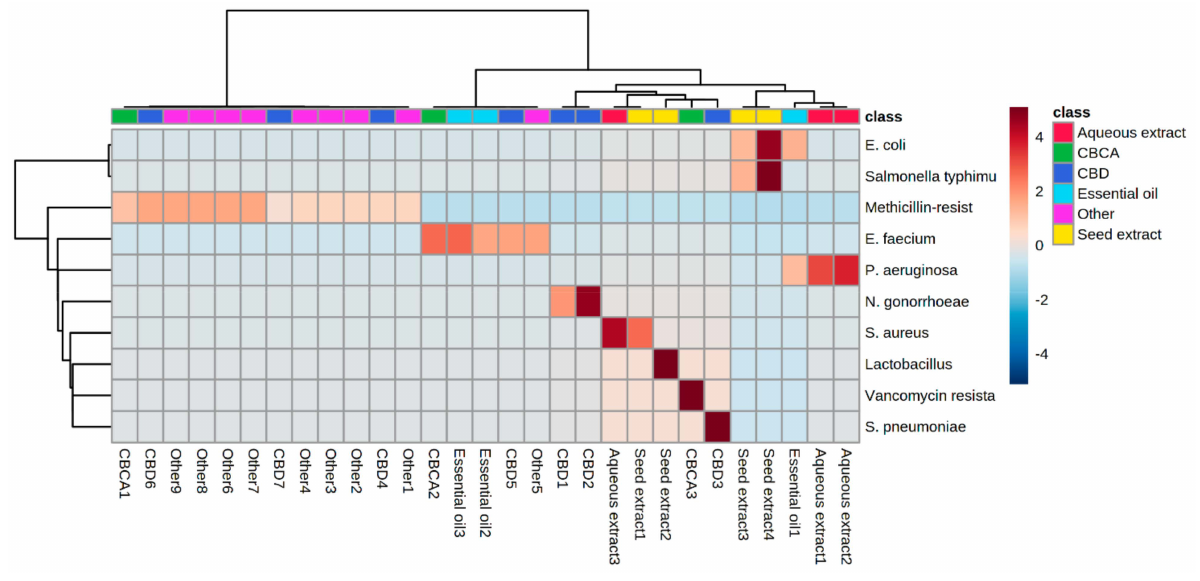
Figure 3. Heat map clusters of different compounds of cannabinoid, illustrating the correlation between samples and different microbial species. The structure produced from MetaboAnalyst from https://www.metaboanalyst.ca/ (accessed on 13 July 2022).